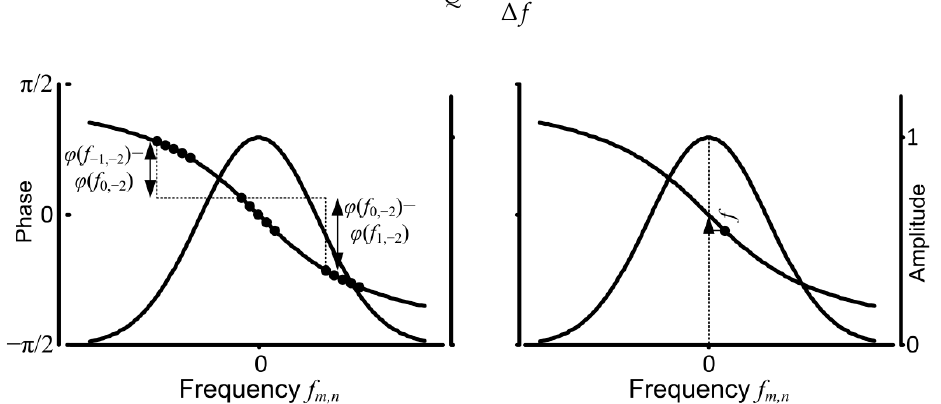
Figure 3. Comparison of the method for the determination of the position of the resonant peak in the cell with the test sample ( left ) and in the control cell with water ( right ). cell with the test sample ( left ) and in the control cell with water ( right